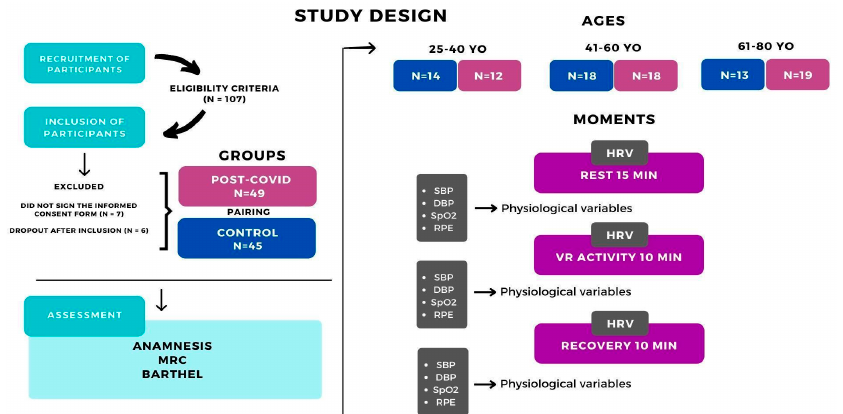
Figure 2. Study design. MRC: Medical Research Council; yo: years-old; HRV: Heart rate variability; VR: Virtual Reality; SBP: Systolic blood pressure; DBP: Diastolic blood pressure; SpO 2 : Peripheral oxygen saturation; RPE: Rating of perceived exertion.